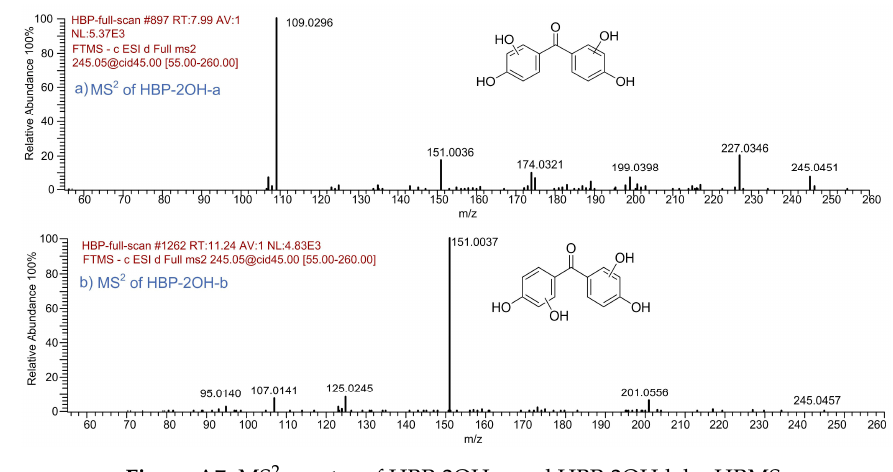
Figure A6. MS 2 spectra of Pr110-a and Pr110-b by HRMS